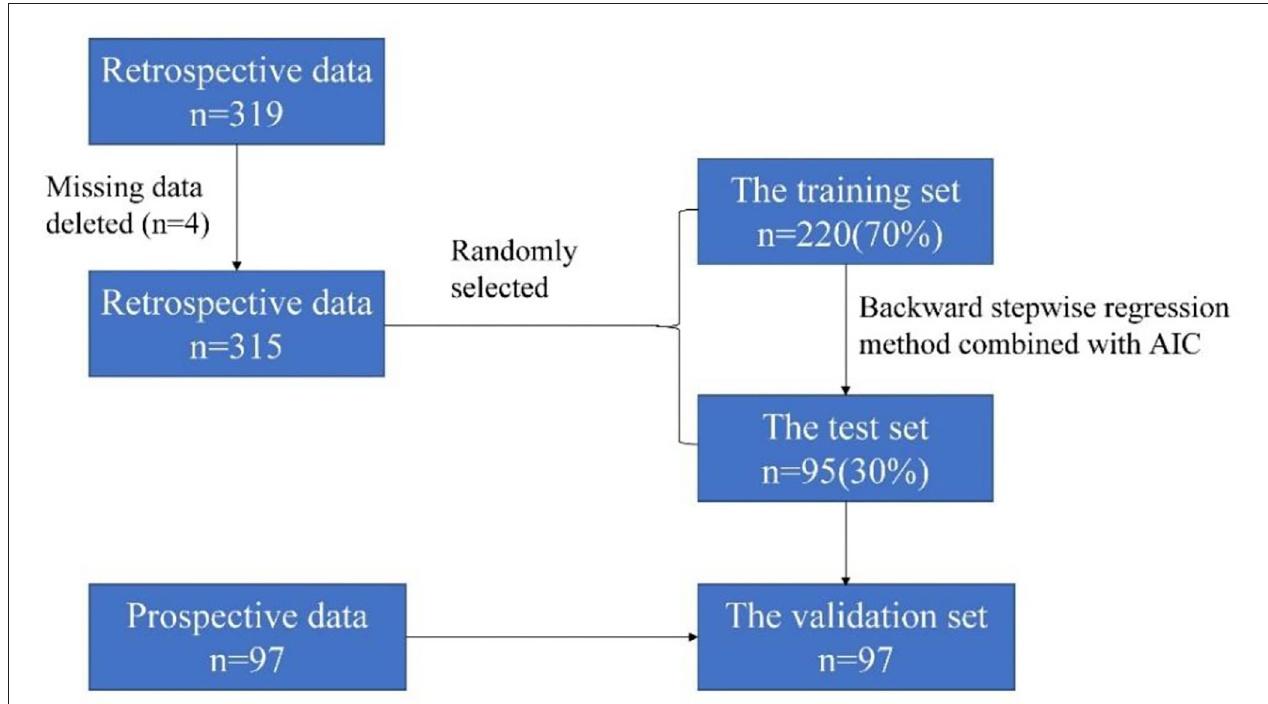
FIGURE 1 | The flowchart in this